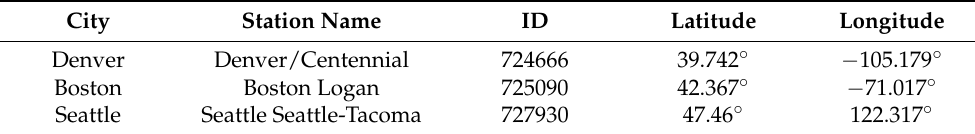
Table 1. Datasets are from the National Solar Radiation Database